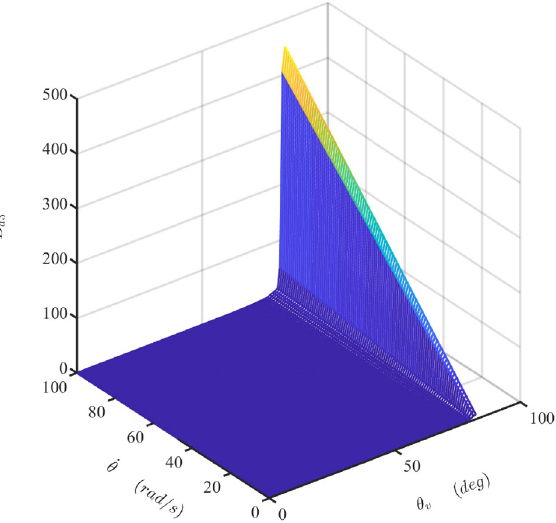
Figure 16. The map of the damper coefficient B a3 (Matlab2019a. https:// ww2. mathw orks. cn/ produ cts/ get- matlab. html?s_ tid= gn_ getml).